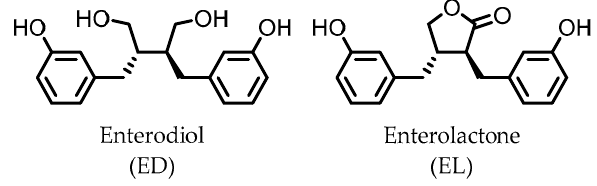
Figure 3. Structures of enterodiol and enterolactone.